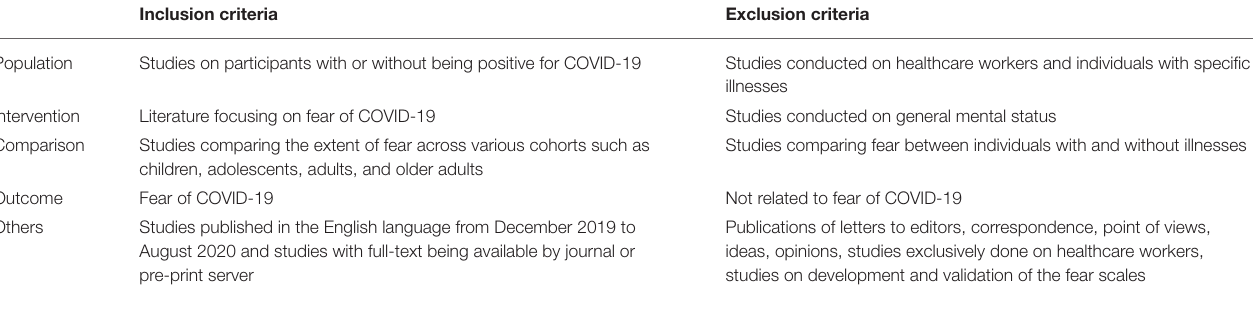
TABLE 1 | Inclusion/exclusion criteria for including studies in the present review.